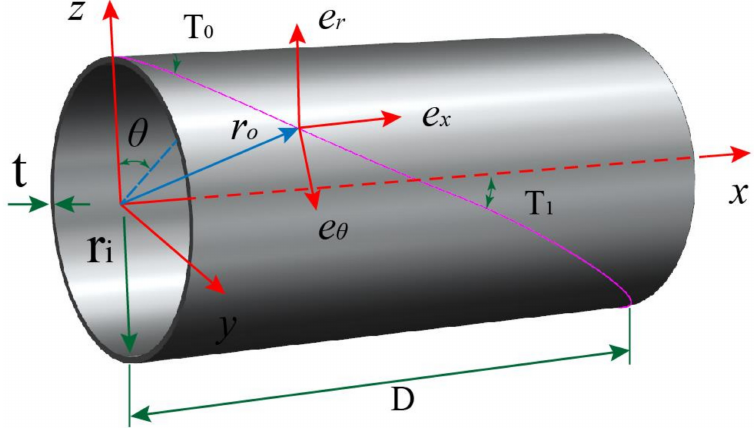
Figure 3. Coordinate axes and variable fiber path on cylinder.